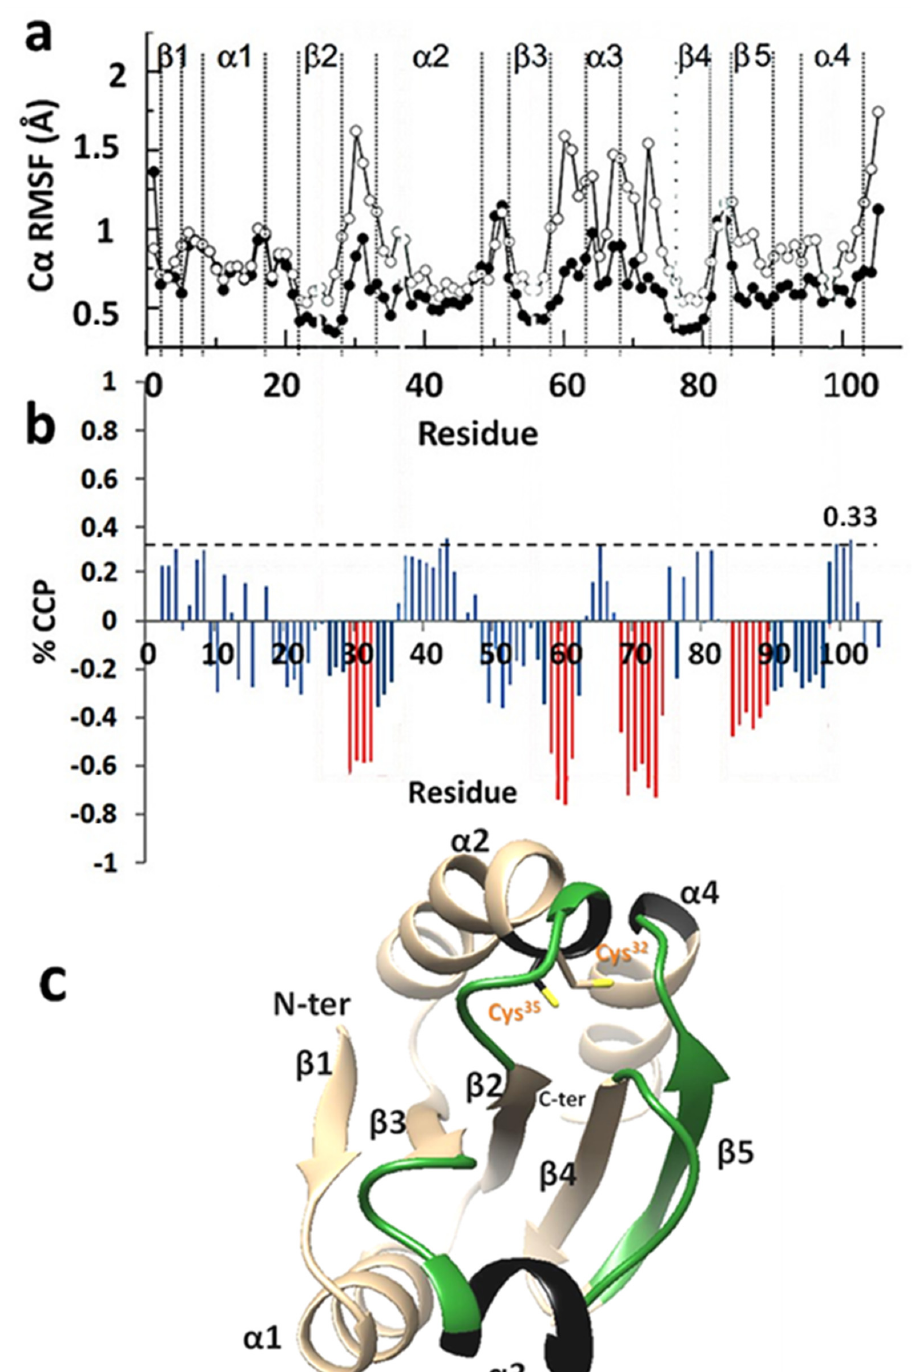
Figure 4. C α root mean square (RMS) fluctuations and percentage of closeness centrality perturbation (% CCP) values of oxidized and reduced human thioredoxin 1 (hTrx1). ( a ) Comparison of C α RMS fluctuations of oxidized (black symbols) and reduced hTrx1 (white symbols) [37]. ( b ) The % CCP values between reduced (PDB ID:1ERT) and oxidized (PDB ID: 1ERU) hTrx1. The red bars indicate negative % CCP values per residues that were above the threshold-noise perturbations of ± 0.33, with the latter value corresponding to segments without any significant change in structure. ( c ) Comparison of flexibilities obtained from MDs and % CCPs for reduced hTrx1. The green areas represent areas with increased flexibility from both methods, and black colored areas are data from MDs. The cysteines of the active site are shown in